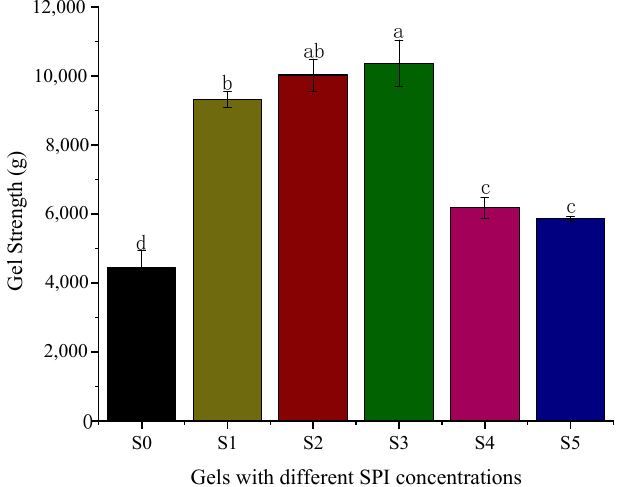
Figure 1. Gel strength of hydrogels. The ratios of gellan gum and soy protein isolate: S0 (0.3:0); S1 (0.3:1); S2 (0.3:2); S3 (0.3:3); S4 (0.3:4); S5 (0.3:5). There were significant differences among the samples with different letters ( p < 0.05).